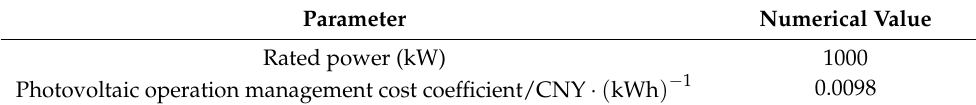
Table 2. The Basic parameters of photovoltaic.